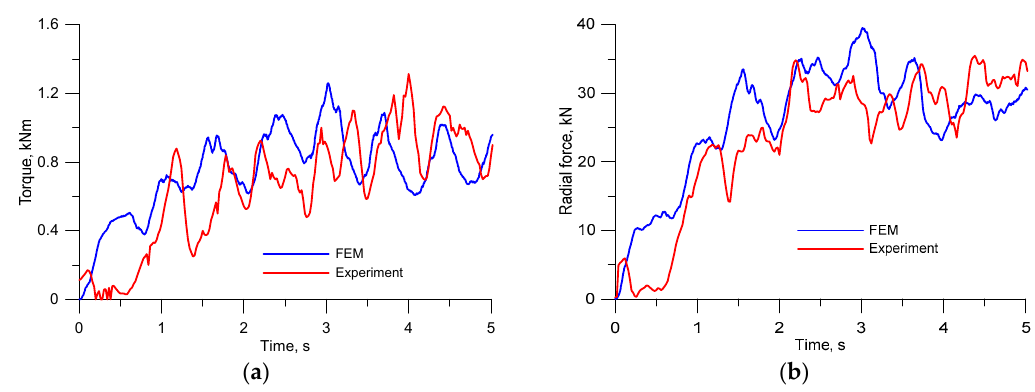
Figure 4. Force parameters in the helical rolling for producing ∅ 33 mm balls: ( a ) Torque; ( b ) radial force.